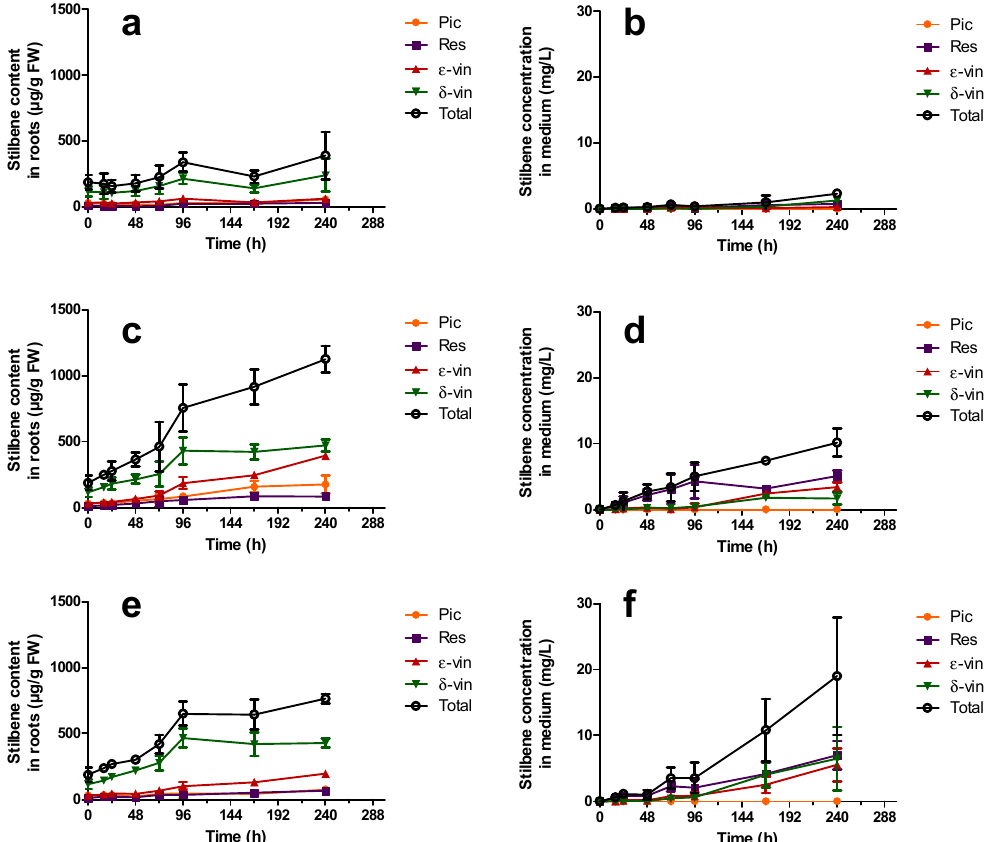
Figure 5. Amounts of stilbenes produced after 18 days of culture following MeJA elicitation in: HRs ( a , c , e ); and in the culture medium ( b , d , f ). ( a , b ) EtOH at 0.1% was used as the control; ( c , d ) 100 µM MeJA; and ( e , f ) 200 µM MeJA. Pic: piceid ( ● ); Res: Resveratrol ( ); ε -vin: ε -viniferin ( ); δ -vin: δ -viniferin ( ); Total ( ○ ) (sum of previous stilbenes). Each point represents the mean with standard